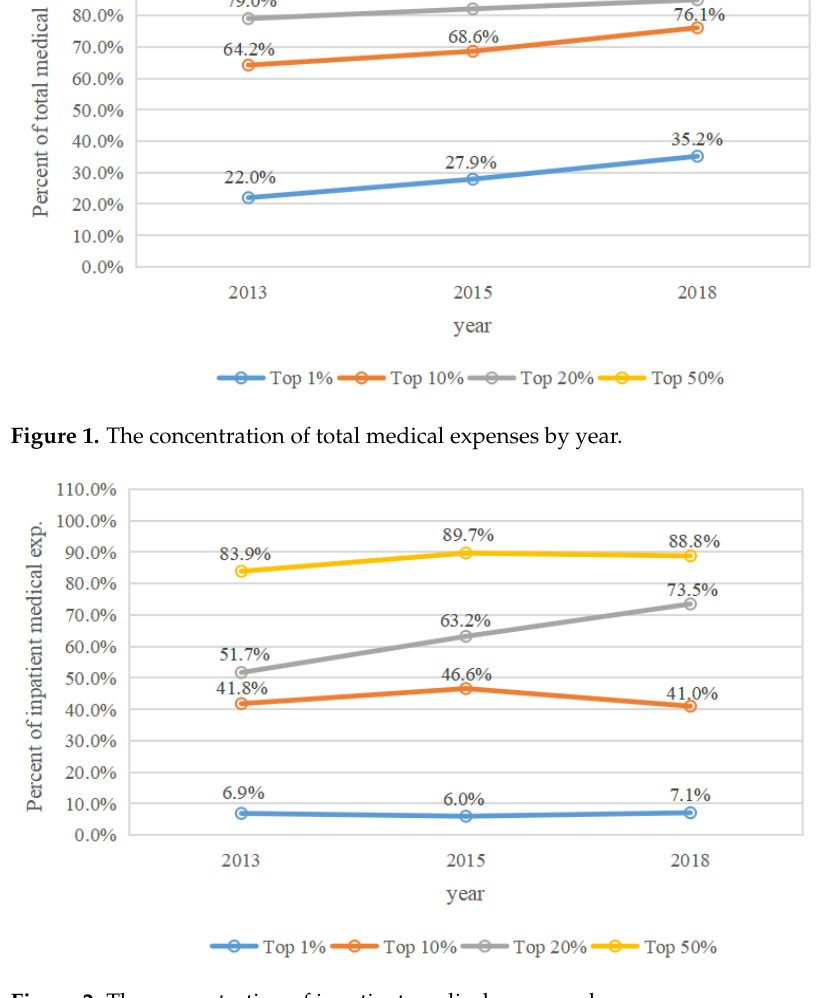
Figure 1. The concentration of total medical expenses by year.